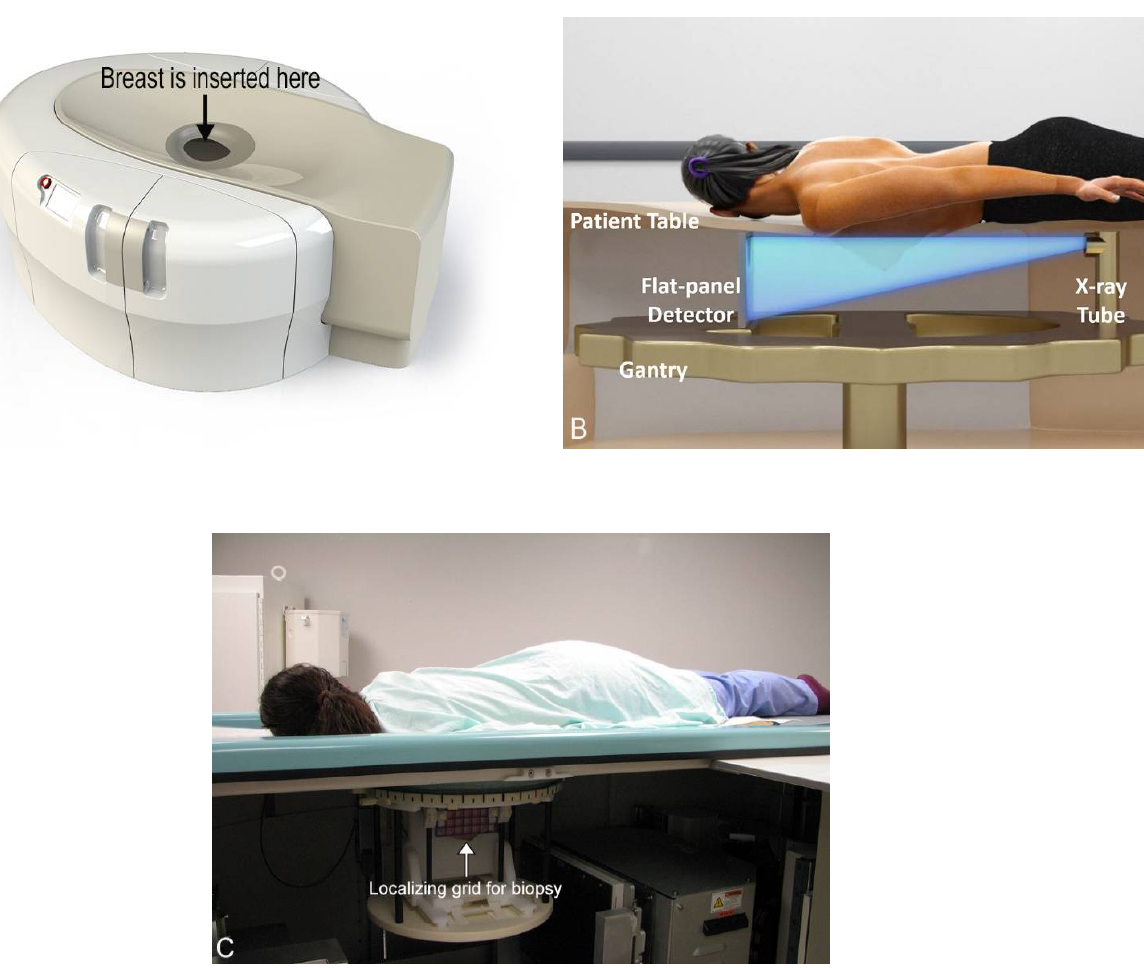
Supplemental Video 1. Video demonstrating how cone-beam breast computed tomography (CBBCT) image acqui- sition occurs.